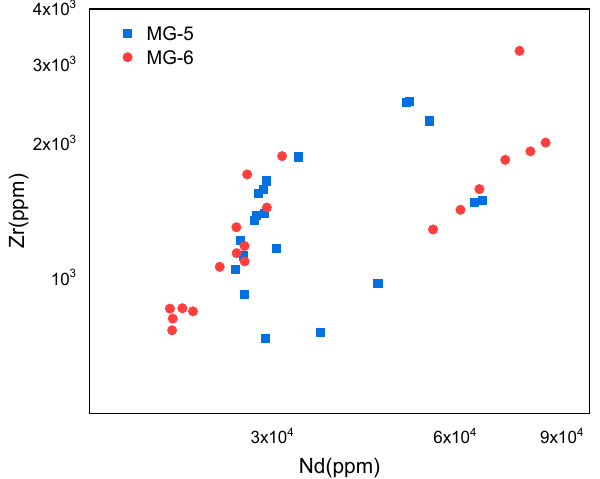
Figure 8. Correlations between Nd (ppm) and Zr (ppm) of titanites.